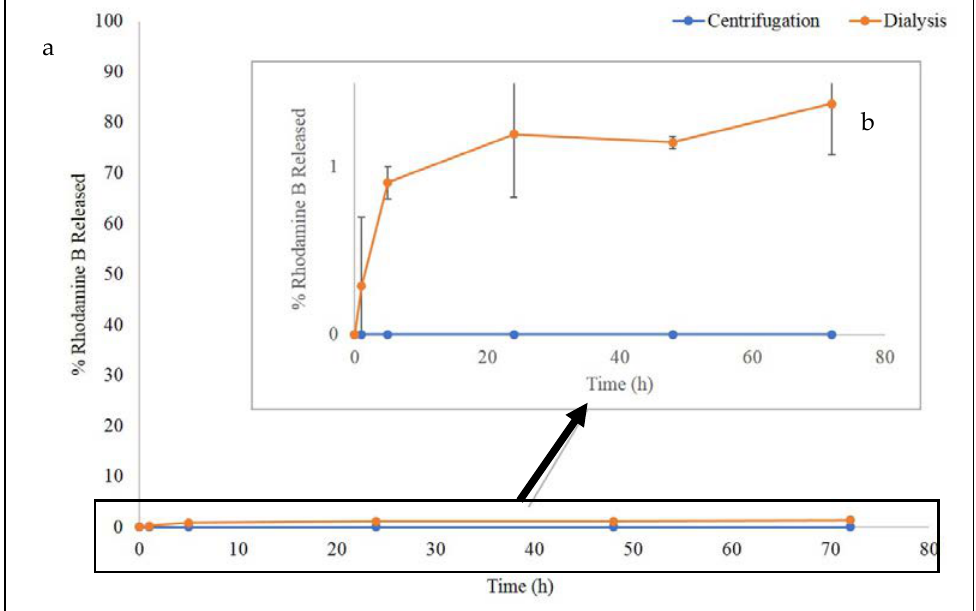
Figure 2. ( a ) Release profile of RhB from loaded-PNPs obtained from two different purification process, at 37 °C for 72 h; ( b ) Magnification of the 1% release profile.